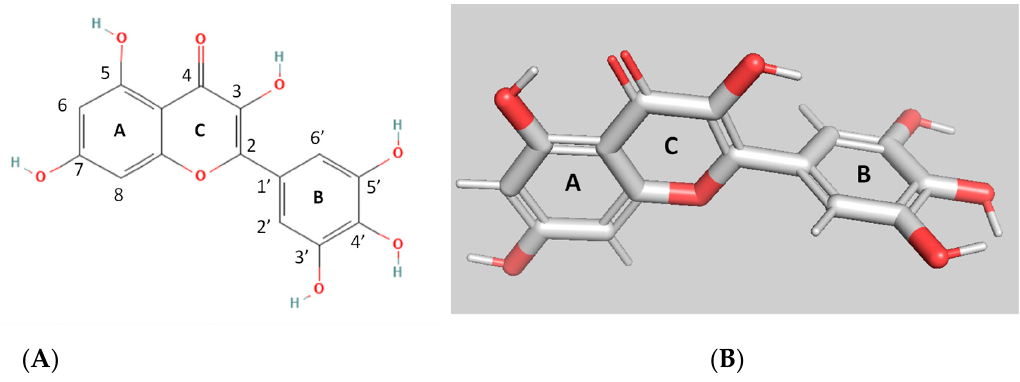
Figure 1. The 2D ( A ); and 3D ( B ) structures of myricetin (MYR). MYR is one of the most common flavonoids in fruits, vegetables, herbs, tea, and red wine and displays a range of diverse bioactivities in different cell processes [21,22], such as apoptosis, glycolysis, cell cycle, energy balance, lipid level, and osteoclastogenesis [21– 24]. In addition, MYR has been shown to affect cancer cells through diverse mechanisms.